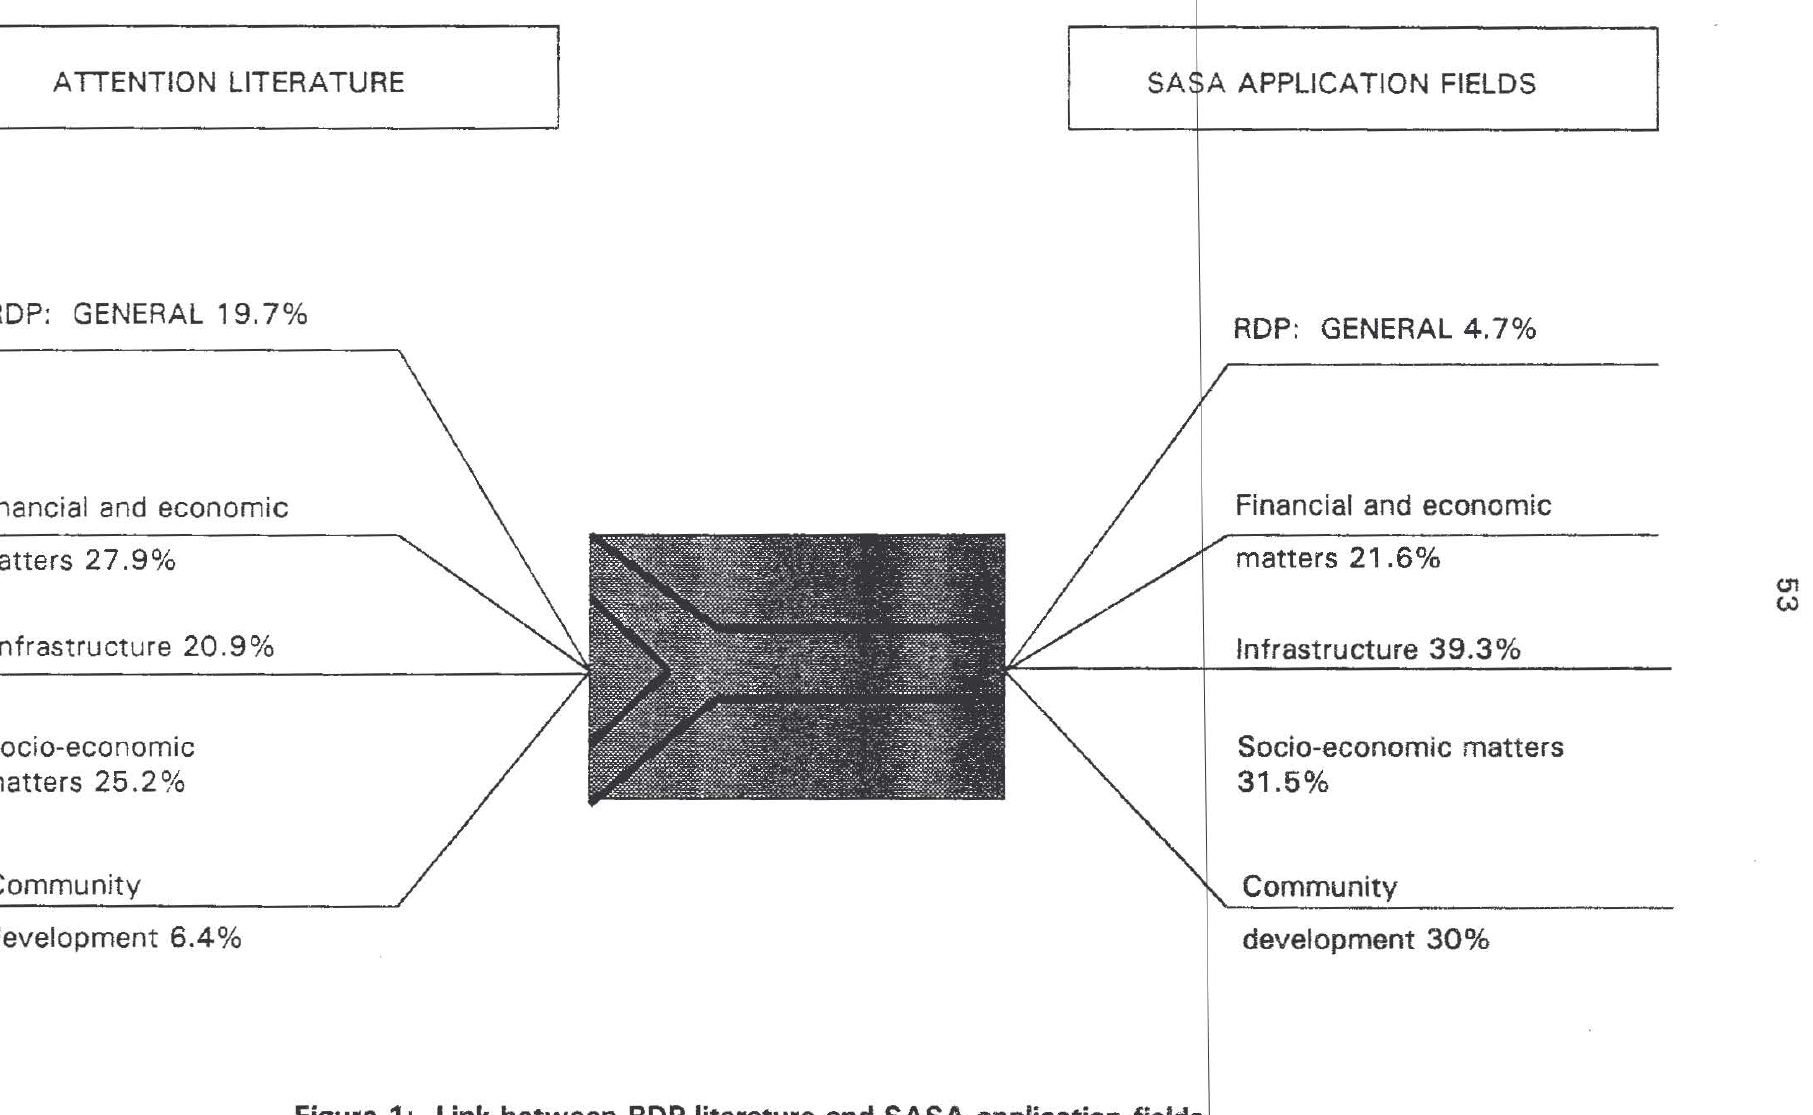
Figure 1: Link between RDP literature and SASA application